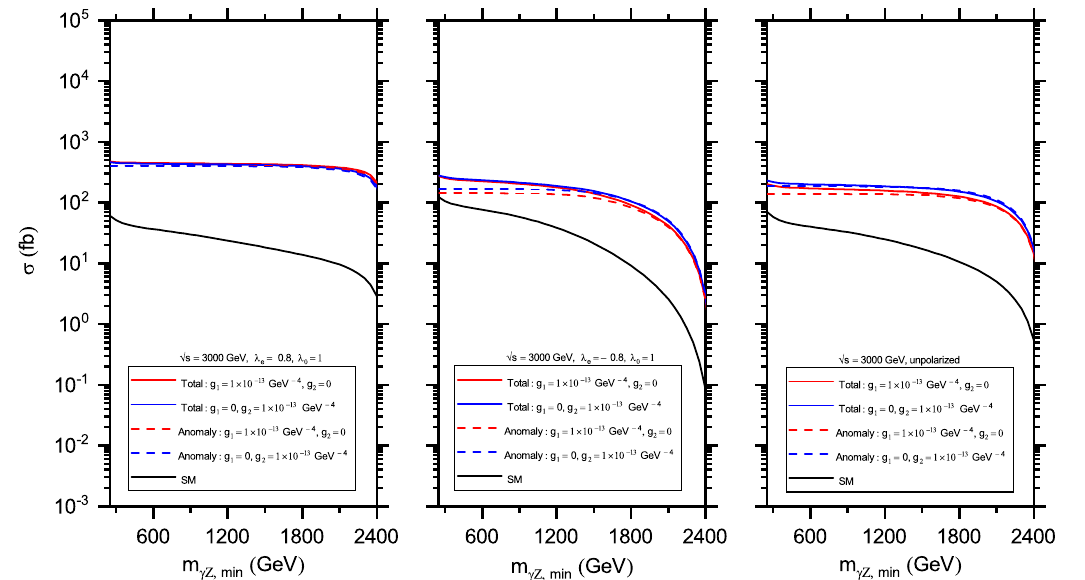
√ s = 3000 GeV, and coupling